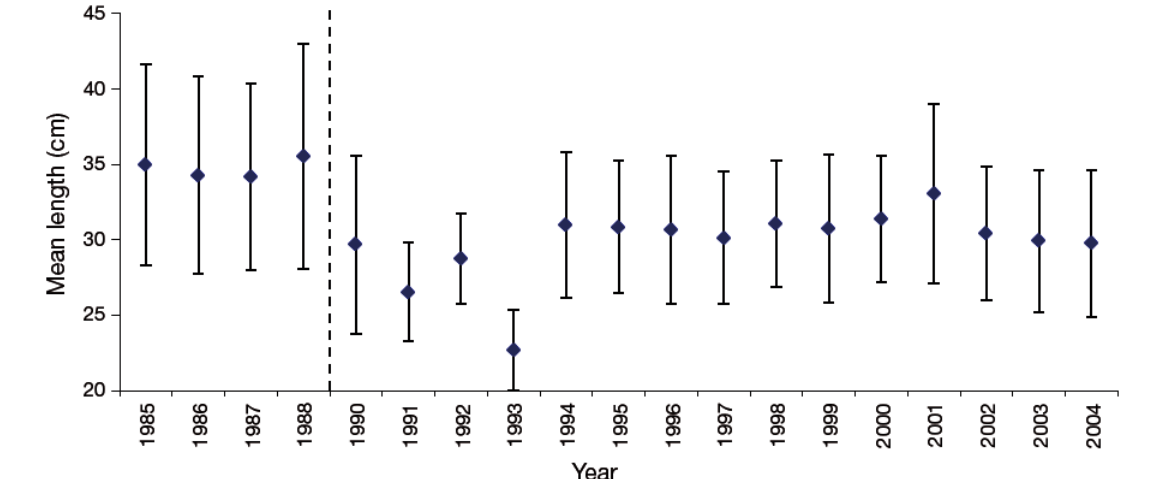
Fig. 5. Mean (± SD) length of sea trout Salmo trutta kelts recorded from the Black River trap, 1985−2004. Kelt data over the period 1985−1988 (to the left of the dashed vertical line) were collected prior to salmon farming